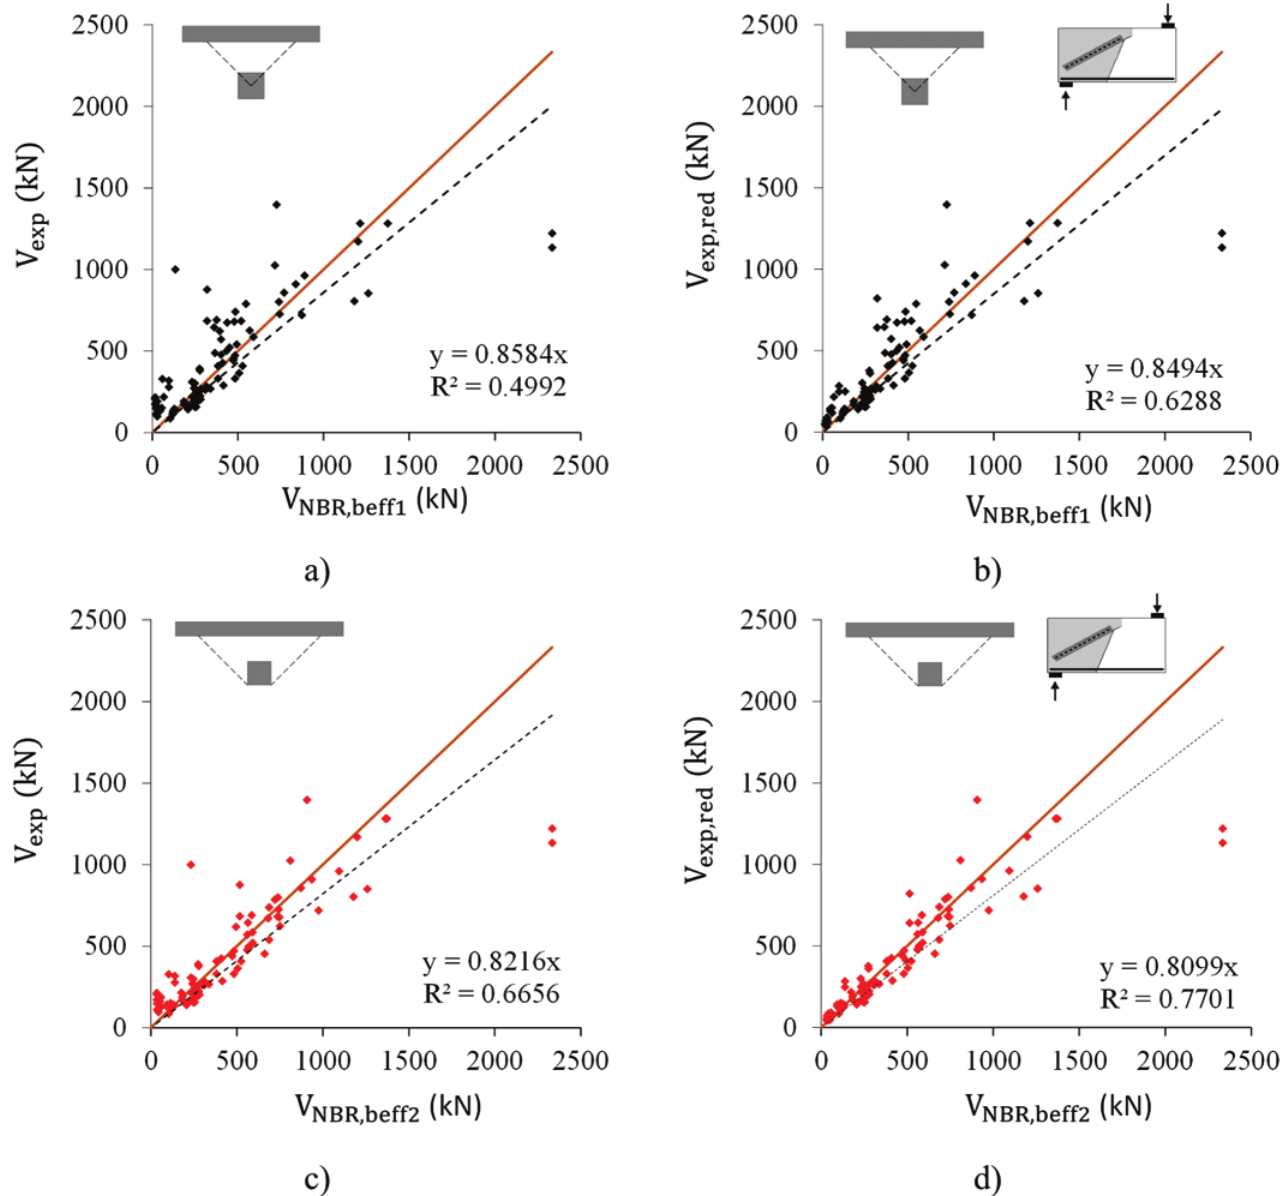
Comparison between experimental and predicted values for shear force strength according to ABNT NBR 6118:2014 [11] a) without β and d) With β and with b EC